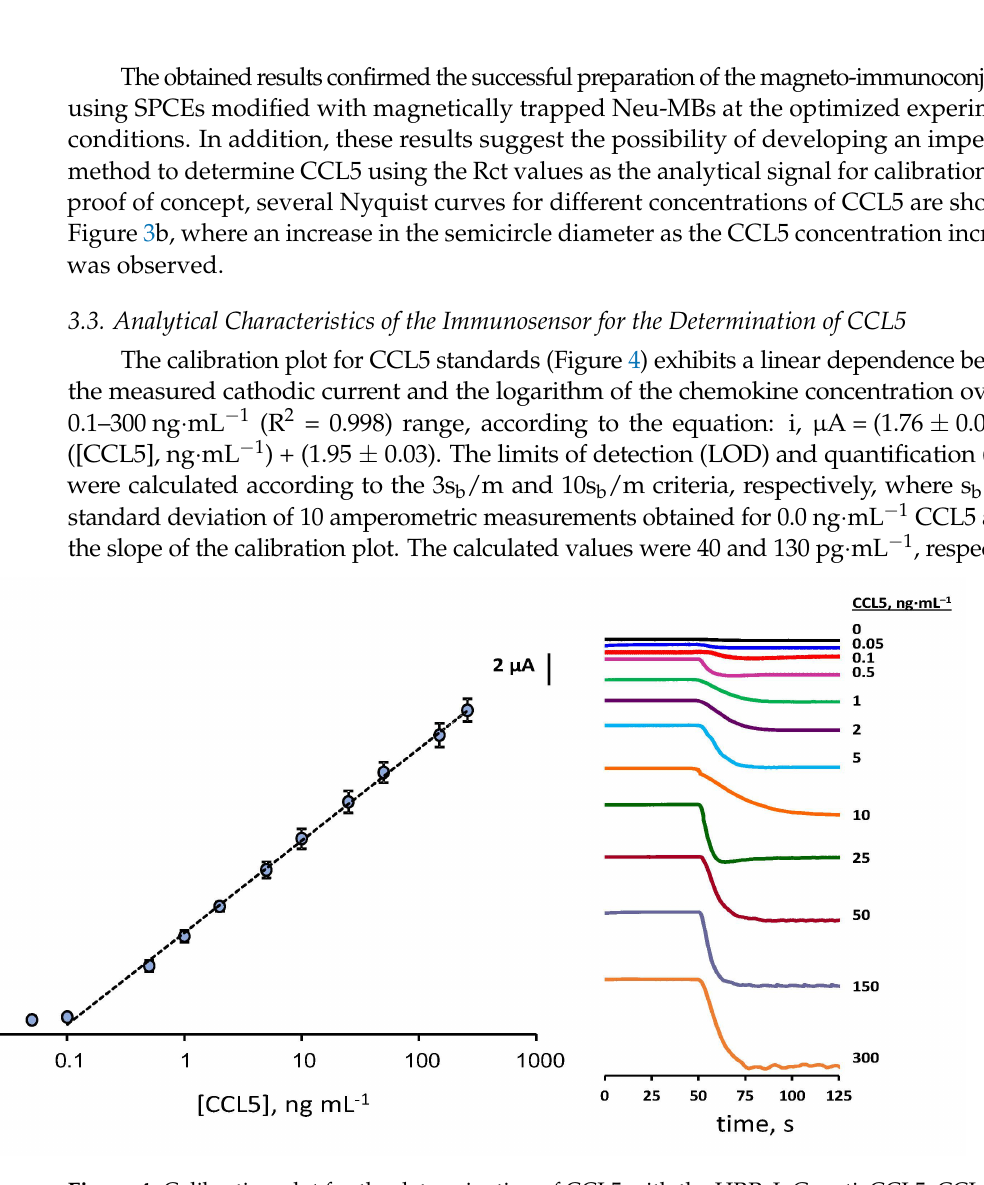
Figure 4. Calibration plot for the determination of CCL5 with the HRP–IgG–anti–CCL5–CCL5–anti– CCL5–Biotin–Neu–MBs/SPCE immunoplatform and real amperometric measurements recorded for different CCL5 concentrations at − 0.20 V vs. Ag pseudo-reference electrode. Error bars are estimated as triple the standard deviation ( n =